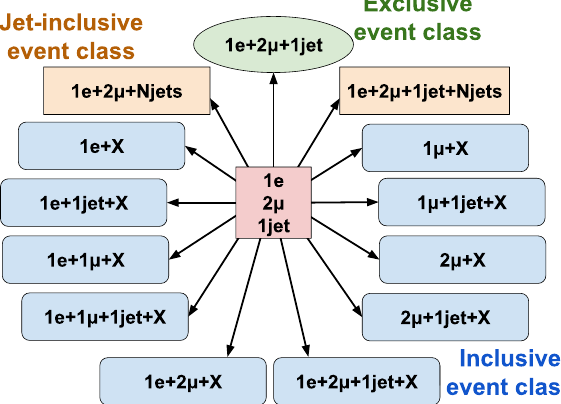
Fig. 1 Illustrative example of classification of a single event (red square) containing one electron, two muons, and one jet. This event will contribute to precisely one exclusive (green), and several inclusive (blue) and jet-inclusive (orange) event